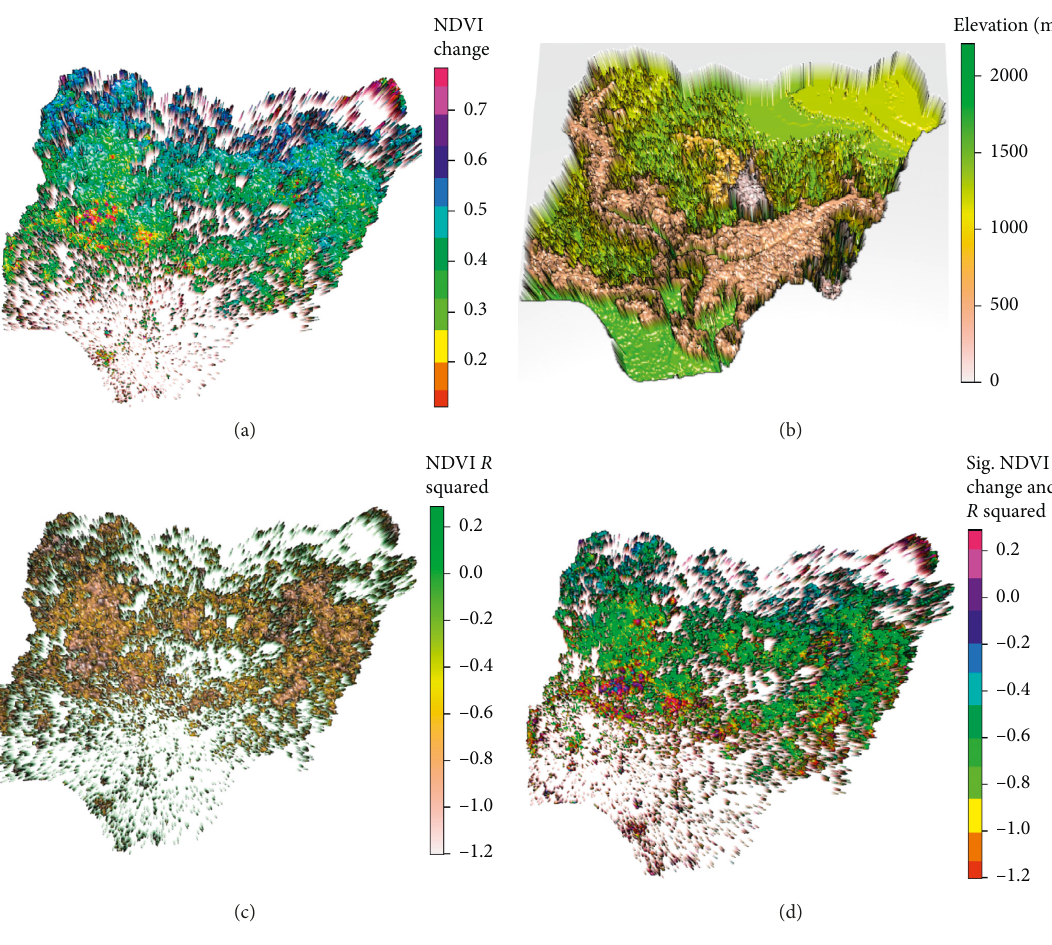
Figure 3: 3D rendering showing areas of (a) significant NDVI change; (b) elevation gradient; (c) NDVI coefficient of determination ( R 2 ); (d) changes in significant NDVI ( R 2 ).